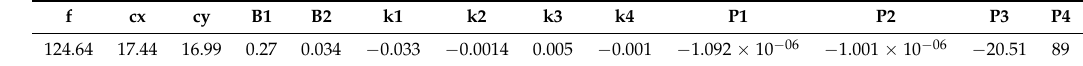
Figure A1. Stability of ( c ) UncYaTT in alignment of data sets acquired with Cumulus clouds covering the sky over Grassland areas in comparison to ( a ) CalYawTT, ( b ) CalTT and ( d ) UncTT and better fit of polynomial regression of PC along Sun azimuth angle. Table A1. Camera distortion